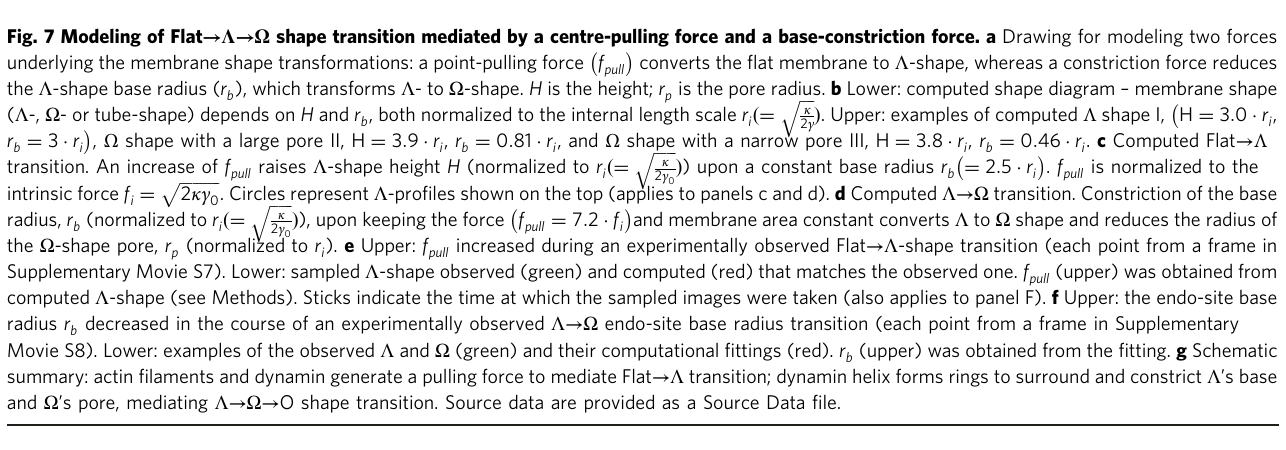
Fig. 7 Modeling of Flat → Λ → Ω shape transition mediated by a centre-pulling force and a base-constriction force. a Drawing for modeling two forces (cid:5) (cid:6) underlying the membrane shape transformations: a point-pulling force f pull converts the fl at membrane to Λ -shape, whereas a constriction force reduces the Λ -shape base radius ( r b ), which transforms Λ - to Ω -shape. H is the height; r p is the pore radius. b Lower: computed shape diagram – membrane shape ffiffiffiffi q (cid:5) κ Þ . Upper: examples of computed Λ shape I, H ¼ 3 : 0 (cid:2) r ( Λ -, Ω - or tube-shape) depends on H and r b , both normalized to the internal length scale r i ð¼ , (cid:6) i 2 γ r ¼ 3 (cid:2) r , Ω shape with a large pore II, H ¼ 3 : 9 (cid:2) r i , r b ¼ 0 : 81 (cid:2) r i , and Ω shape with a narrow pore III, H ¼ 3 : 8 (cid:2) r i , r b ¼ 0 : 46 (cid:2) r i . c Computed Flat → Λ ffiffiffiffiffiffi q (cid:5) (cid:6) b i κ ¼ 2 : 5 (cid:2) r Þ ) upon a constant base radius r transition. An increase of f pull raises Λ -shape height H (normalized to r i ð¼ . f pull is normalized to the ffiffiffiffiffiffiffiffiffiffi p b i 2 γ 0 intrinsic force f i ¼ 2 κγ . Circles represent Λ -pro fi les shown on the top (applies to panels c and d). d Computed Λ → Ω transition. Constriction of the base ffiffiffiffiffiffi q (cid:5) (cid:6) 0 κ ¼ 7 : 2 (cid:2) f Þ ), upon keeping the force f radius, r b (normalized to r i ð¼ and membrane area constant converts Λ to Ω shape and reduces the radius of pull i 2 γ 0 the Ω -shape pore, r p (normalized to r i ). e Upper: f pull increased during an experimentally observed Flat → Λ -shape transition (each point from a frame in Supplementary Movie S7). Lower: sampled Λ -shape observed (green) and computed (red) that matches the observed one. f pull (upper) was obtained from computed Λ -shape (see Methods). Sticks indicate the time at which the sampled images were taken (also applies to panel F). f Upper: the endo-site base radius r b decreased in the course of an experimentally observed Λ → Ω endo-site base radius transition (each point from a frame in Supplementary Movie S8). Lower: examples of the observed Λ and Ω (green) and their computational fi ttings (red). r b (upper) was obtained from the fi tting. g Schematic summary: actin fi laments and dynamin generate a pulling force to mediate Flat → Λ transition; dynamin helix forms rings to surround and constrict Λ ’ s base and Ω ’ s pore, mediating Λ → Ω → O shape transition. Source data are provided as a Source Data fi